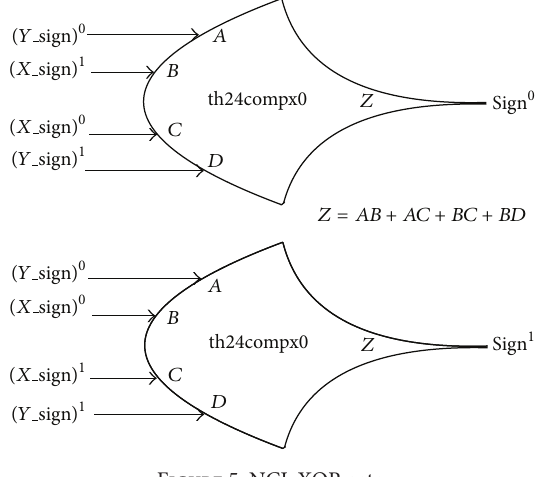
Figure 5: NCL XOR gate.